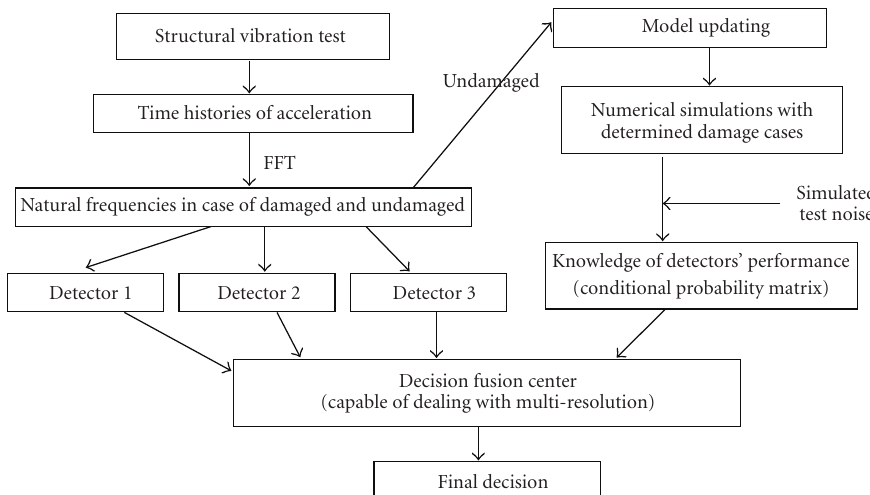
Figure 7: Decision fusion-based damage detection.